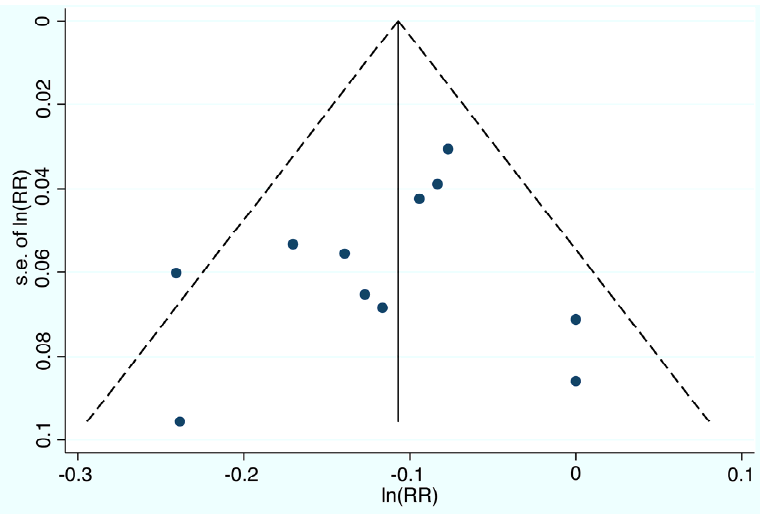
Figure 3. Funnel plot with pseudo 95% confidence limits . RR=relative risk; s.e.= standard error.